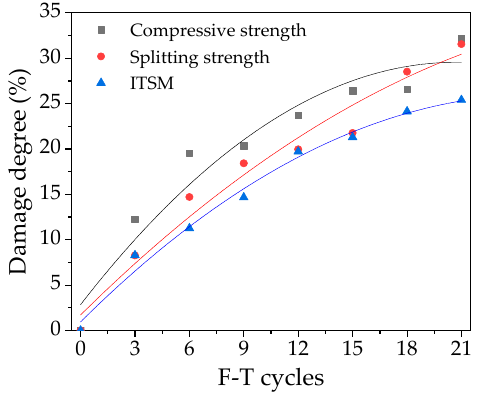
Figure 9. Damage evolution of the asphalt mixture.